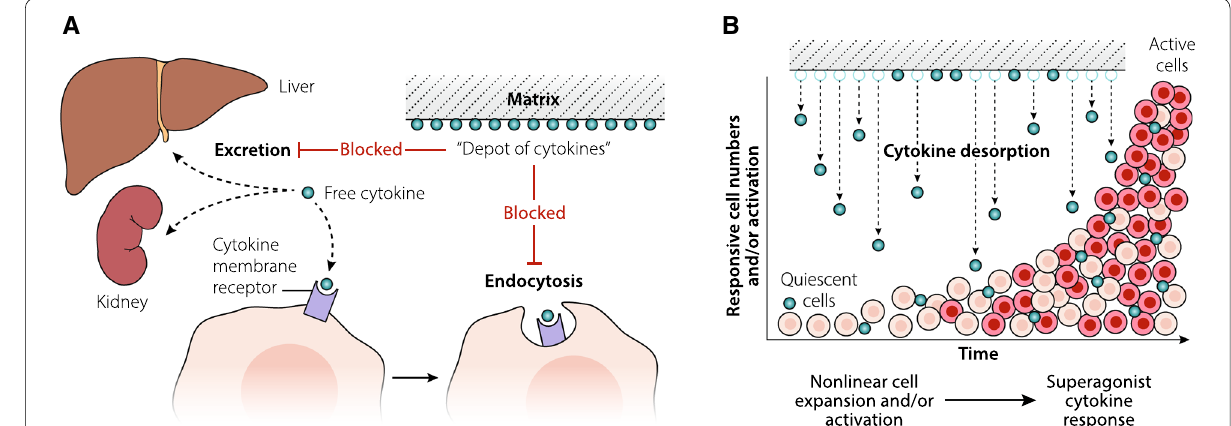
Fig. 3 Cytokine rescue and depot. A The fast clearance of free cytokines principally results from renal and hepatic excretion and metabolism, and receptor clearance by endocytosis. Cytokine adsorption to a matrix could “rescue” the cytokine from renal or hepatic excretion and metabolism and prevent receptor binding and endocytosis. Cytokine adsorbed to matrix could form a “depot of cytokines”. B Gradual desorption of cytokine from the matrix “depot” over time could provide a sustained, low level of cytokine agonist to responsive cells. Nonlinear cell responses to sustained low cytokine levels could drive a “superagonistic” inflammatory response contrary to the therapeutic intention of adsorptive